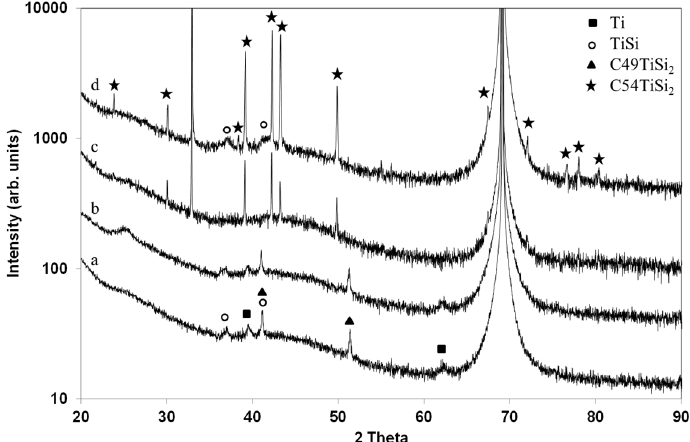
Figure 5. X-ray diffraction patterns of Ti films, 250 nm thick, heated at 500 ◦ C and processed in (Ar-33%N 2 -1%H 2 ) for ( a ) 1.5 h and ( b ) 3 h, and Ti films, ( c ) 250 nm thick, and ( d ) 500 nm thick heated at 600 ◦ C and processed in (Ar-33%N 2 -1%H 2 ) for 30 min.